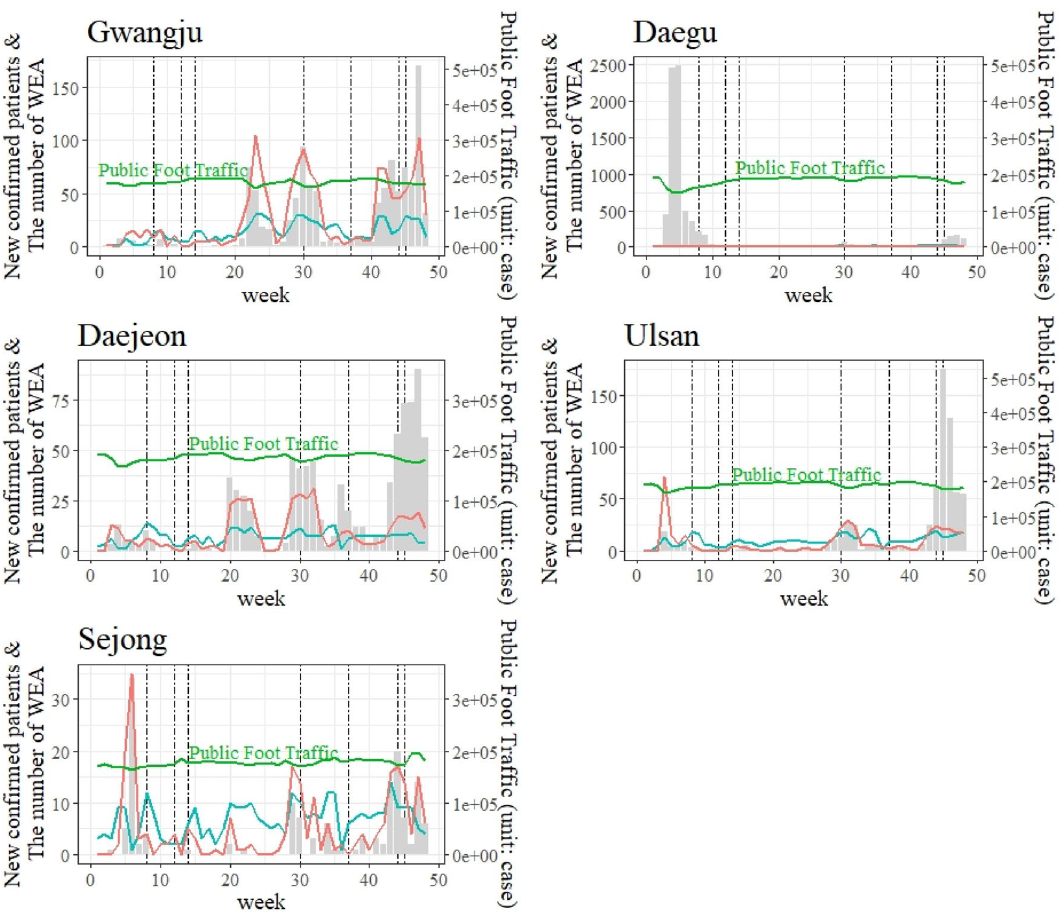
Figure 3. The weekly changes of confirmed COVID-19 cases and WEA messages in the target areas. The grey bar shows the number of weekly confirmed cases. The red line indicates the number of “warning” topic messages, the blue line is the “guidance” topic, and the green line shows the daily average public foot